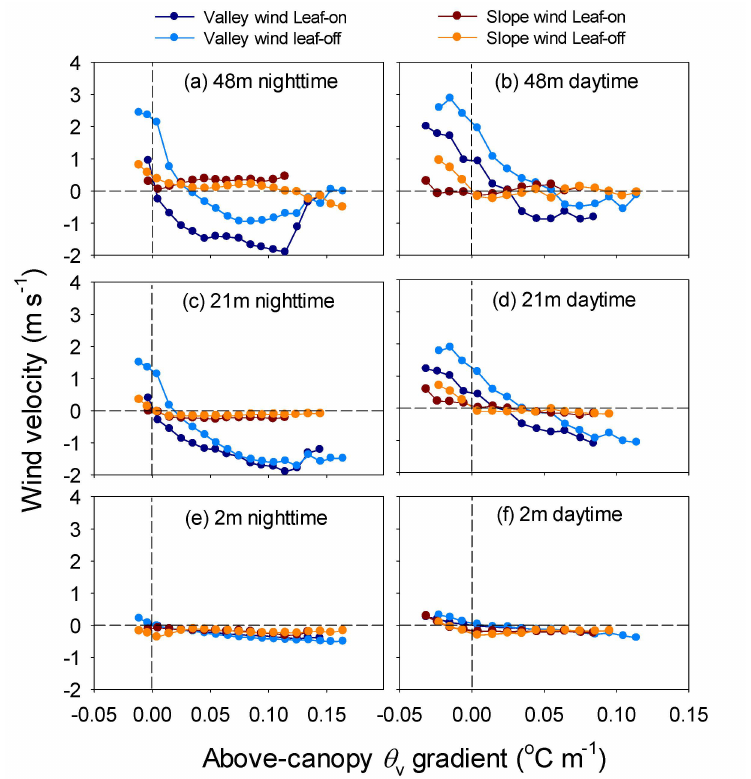
Figure 11. Changes of mean along-valley and cross-valley wind velocities at the 48 m, 21 m and 2 m with the gradient of above-canopy virtual potential air temperature (θ v ) in 2012. ( a ) and ( b ) are at 48 m in the nighttime and daytime, respectively. ( c ) and ( d ) are at 21 m in the nighttime and daytime, correspondingly. ( e ) and ( f ) are at 2 m in the nighttime and daytime, respectively.